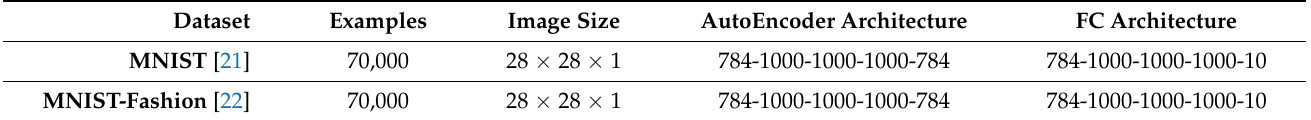
Table 1. Details of datasets and their architectures used in my